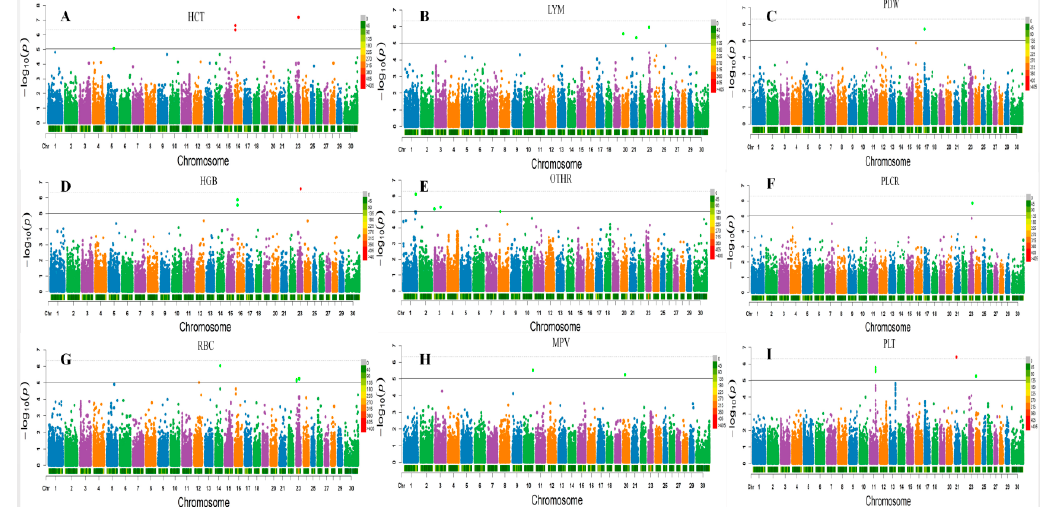
Figure 1. A portion of the GWAS results of hematological traits at a significant level in Polled yak. X axis indicates chromosome, Y axis indicates − lg ( p -value), the solid line indicates genome-wide significant level and the dashed line indicates the chromosome-wide significance level, the bars below each chromosome are the density of the markers. RBC: red blood cell count. HCT: hematocrit; HGB: hemoglobin; OTHR: medium white blood cell count; PLT: platelet count; MPV: mean platelet volume; PLCR: platelet count; LYM: lymphocyte count; PDW: platelet distribution width.( A – I ) Manhattan plot representing HCT, LYM, PDW, HGB, OTHR, PLCR, RBC, MPV and PLT traits, respectively.